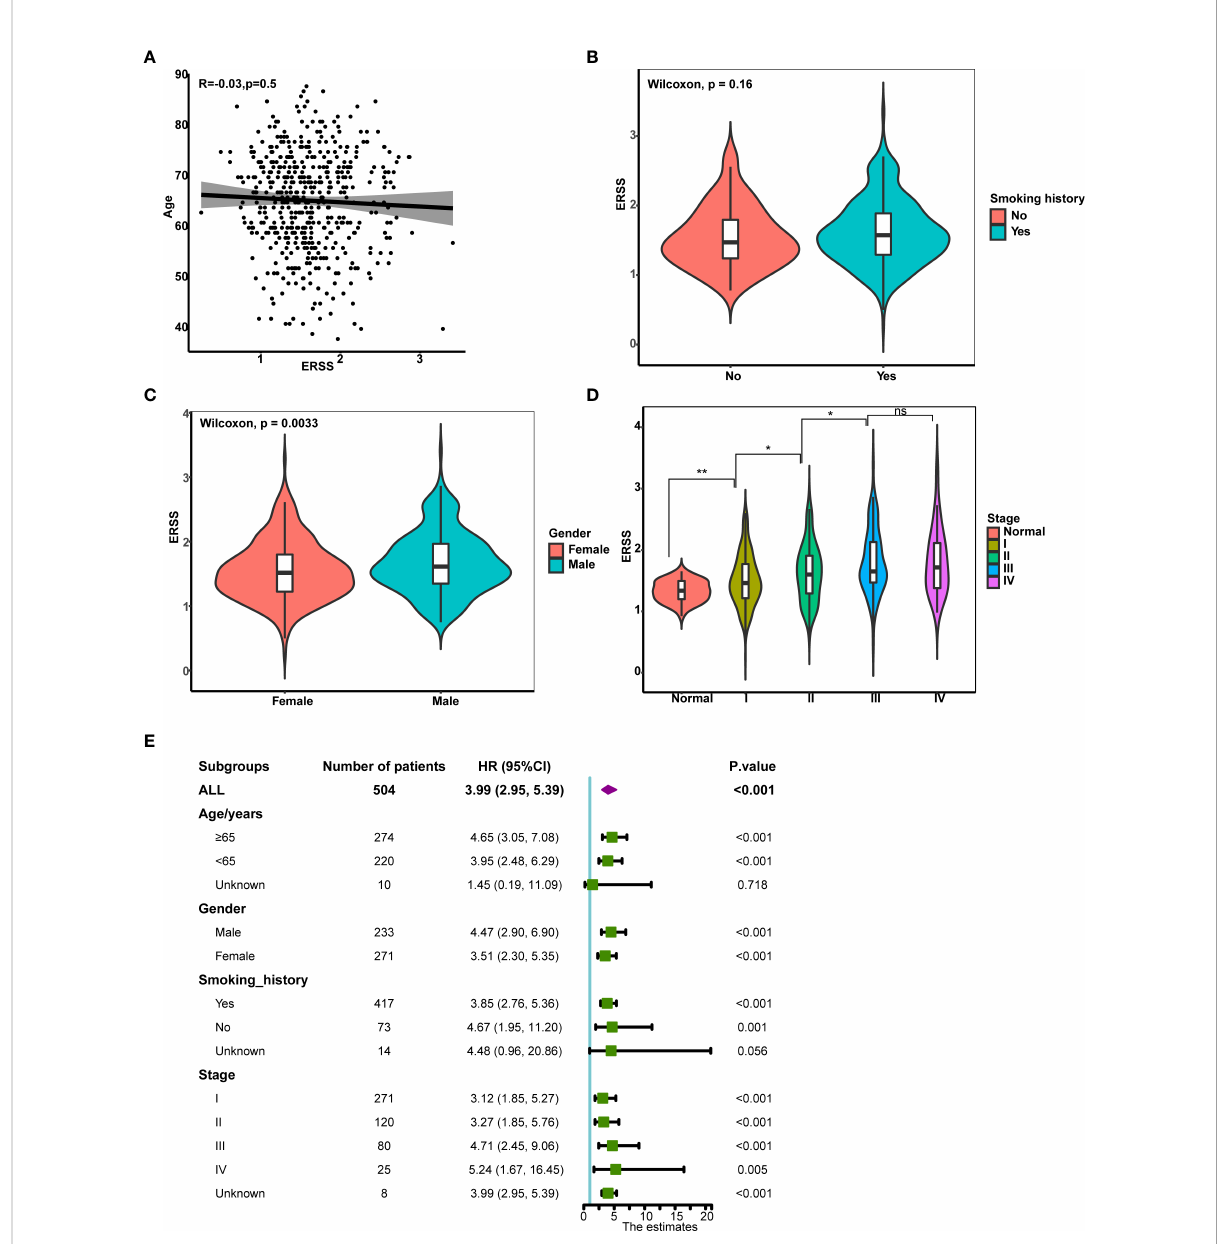
FIGURE 4 The correlation between clinical features and ERSS in TCGA cohort. (A) ERSS had no correlation with age. (B) Men had higher ERSS compared with women. (C) Smoking history had no association with ERSS. (D) Patients with advanced stage showed signi fi cantly higher ERSS than patients with early stage. (E) High ERSS signi fi cantly correlated with worse OS in different subgroups. ERSS, endoplasmic reticulum stress score; TCGA, The Cancer Genome Atlas; OS, overall survival. * p <0.05, ** p <0.01, ns means p